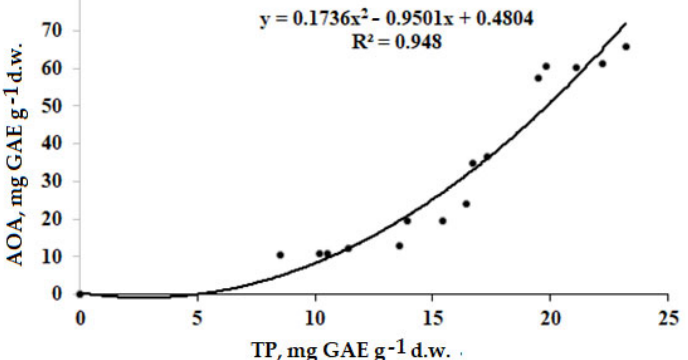
Figure 2. Correlation between AOA and TP in A. annua control plants and plants supplied with selenate (+6) and nano-Se (r = 0.974, p < 0.0001).